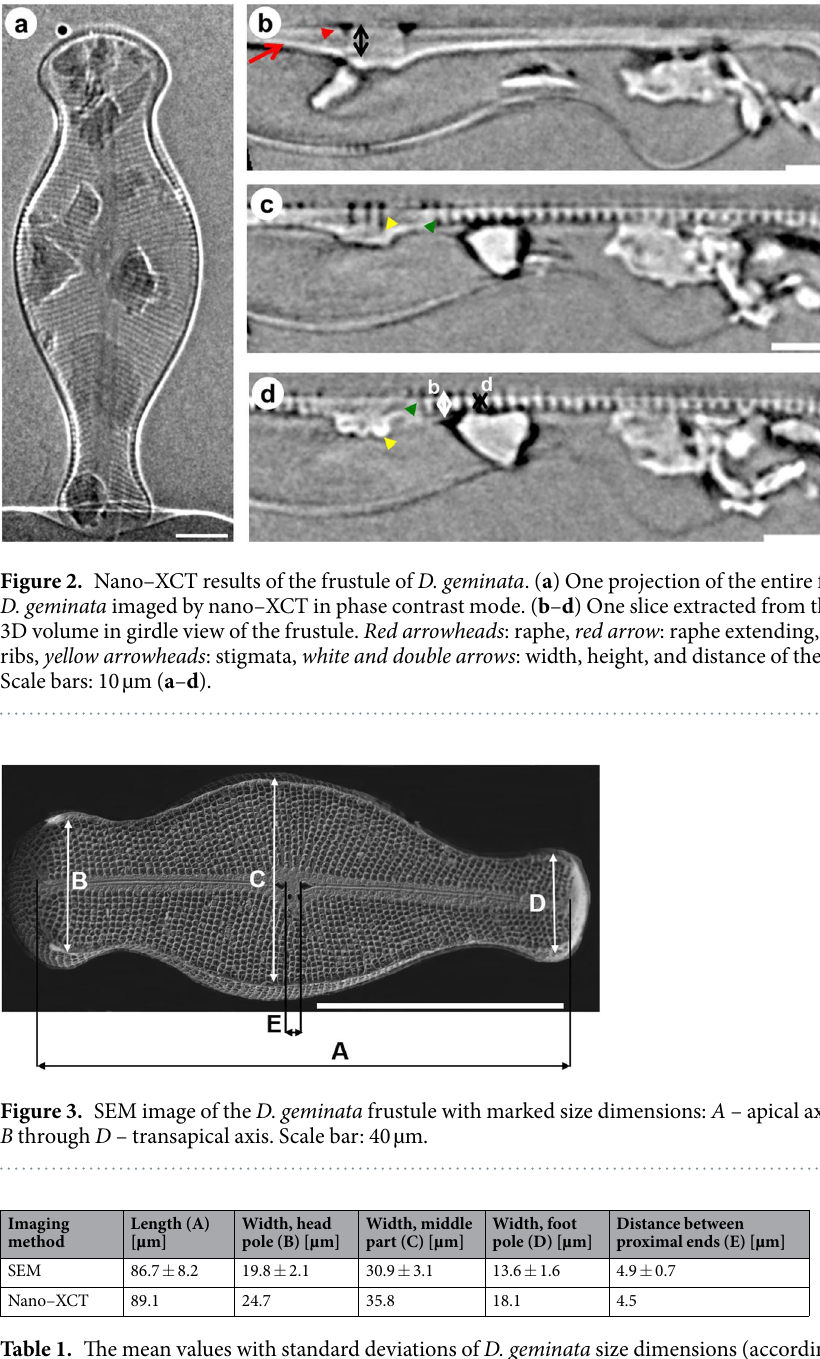
Table 1. The mean values with standard deviations of D. geminata size dimensions (according to the designation in Figs